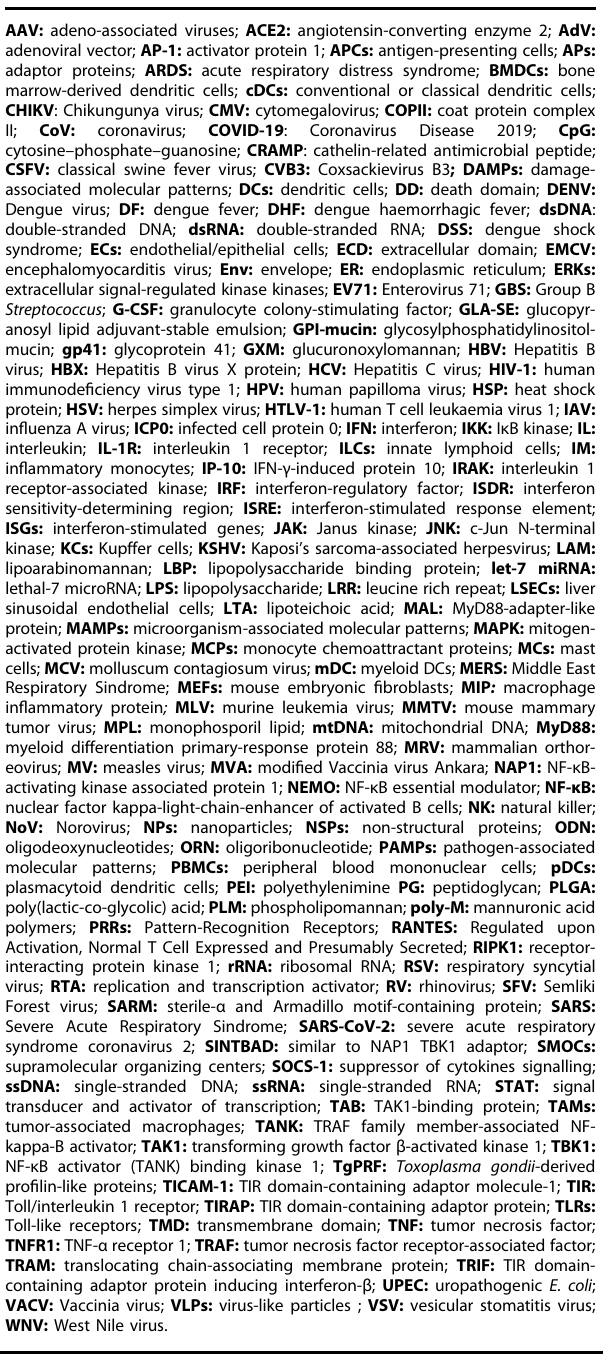
Within endosomes, cathepsins and proteases promote cleavage of TLR ectodomains, a prerequisite for signal transduction 3,22 . TLRs detect a wide spectrum of microbial components, host- derived ligands (Table 1), or synthetic compounds (detailed afterwards). Interaction with ligands (or agonists) induces homodimerization or heterodimerization of TLR ectodomains, with subsequent dimerization of their intracellular domains, recruitment of signal- ing adapters, and activation 14,15,18 . Cell-surface TLRs mainly bind to proteins, lipids, and lipoproteins (TLR1, etc.), while intracellular TLRs detect nucleic acids (NAs; TLR3, TLR7, TLR8, TLR9, TLR13) or